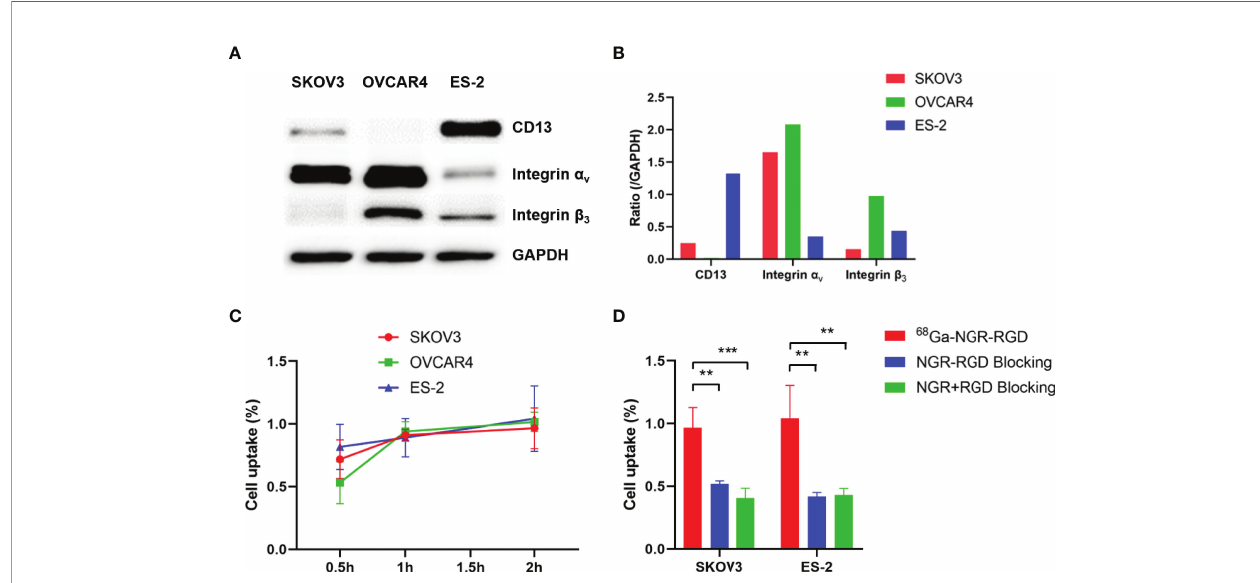
FIGURE 1 | Evaluation of binding af fi nity of 68 Ga-NGR-RGD to ovarian tumor cells. (A) Western blot analysis of expression of CD13, integrin a v and integrin b 3 in three ovarian tumor cell lines, with GAPDH used as internal control. (B) The semi-quantitative analysis was conducted through the integrated optical density ratio of CD13, integrin a v and integrin b 3 to GAPDH. (C) Uptake of 68 Ga-NGR-RGD in SKOV3, OVCAR4 and ES-2 ovarian tumor cell lines at 0.5 h, 1 h, 2 h. (D) Uptake of 68 Ga-NGR-RGD in SKOV3 and ES-2 cells with or without blocking dose of NGR-RGD or NRG + RGD at 2 h. Cell uptake and blocking assays showed the 68 Ga-NGR-RGD displayed speci fi c binding to ovarian tumor cell lines. **p < 0.01, ***p < 0.001. Data are expressed as mean ± SD (n =